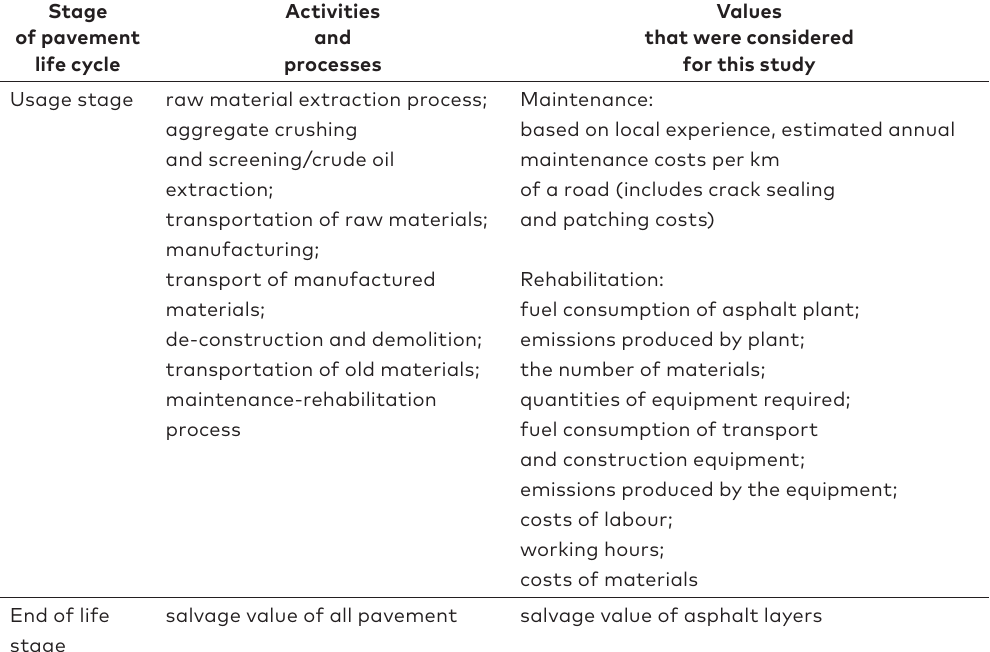
Table 4. Activities and processes that are